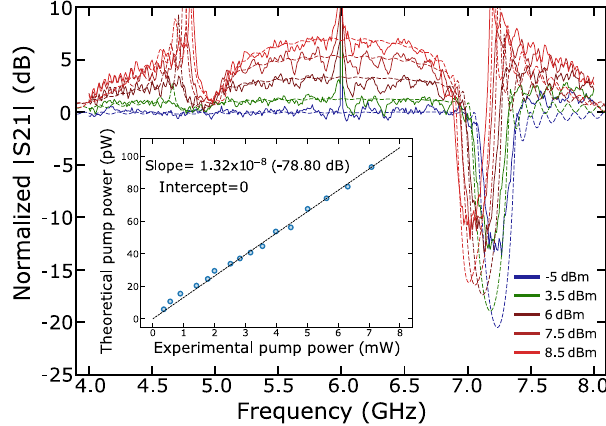
FIG. 12. Measurement setup. Configuration ① is a standard microwave transmission measurement setup. Configuration ② has one more input line. This configuration can be used for the same purpose as ① (pump and signal propagate in the same direction), or to probe backward gain (pump and signal propagate in opposite directions). Attenuators and filter of the leftmost and middle rf lines are nominally identical.